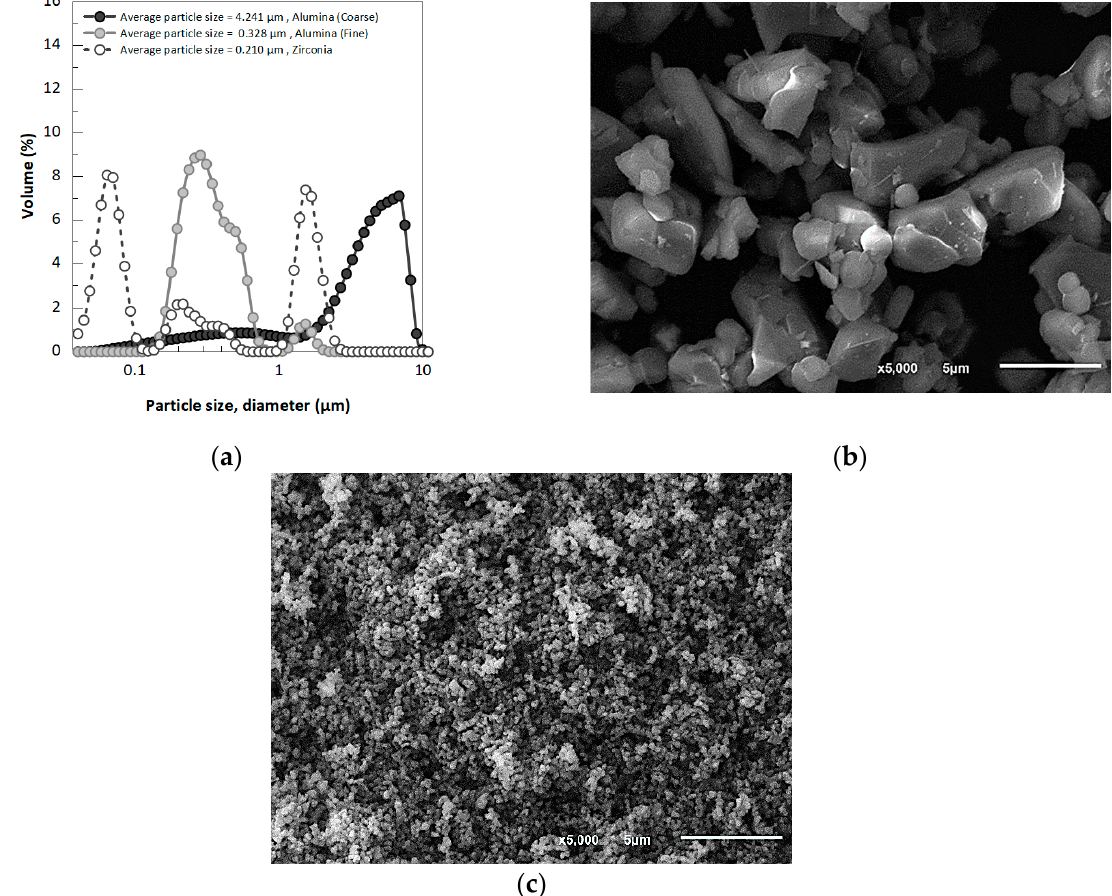
Figure 3. ( a ) Particle size distributions of alumina and zirconia; Typical SEM images of as-received alumina particles are shown: ( b ) coarse, and ( c ) fine .